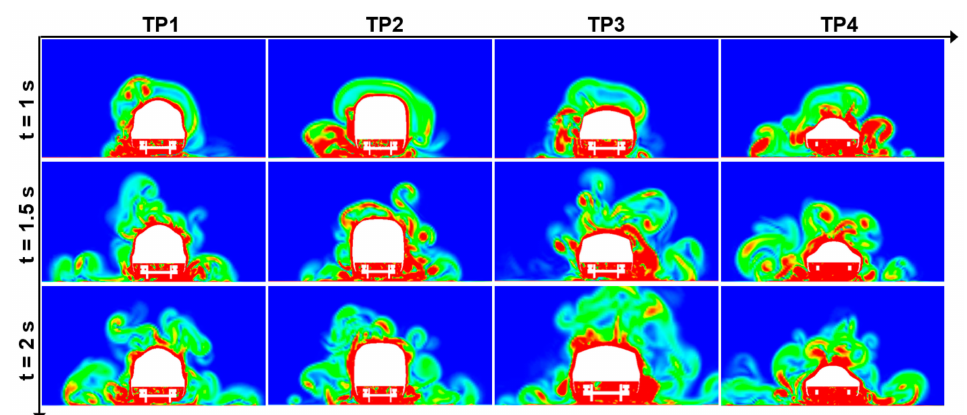
Figure 17. Contour of vorticity at x = 95 m at different timesteps for the four